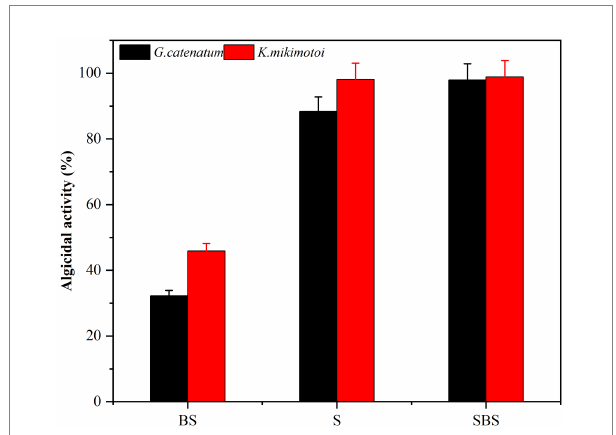
FIGURE 4 Algicidal activity of different composition to G. catenatum (A) and K.